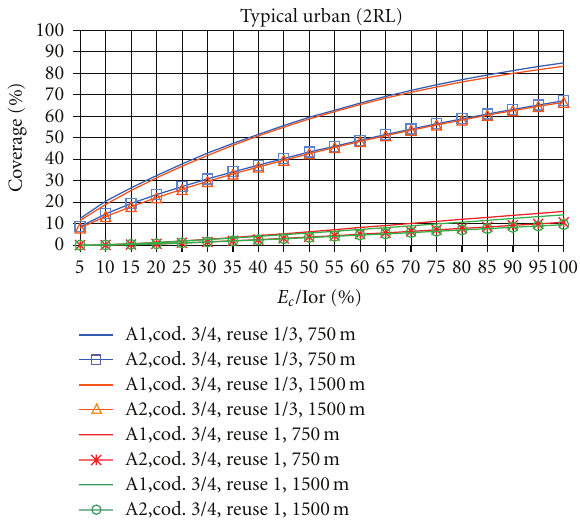
Figure 15: MIMO coverage (%) versus E c /Ior (%), for SC-PTM scenario, cod. 3 /